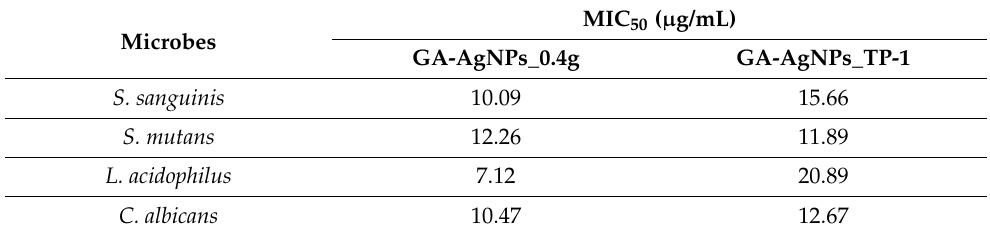
Table 5. MIC 50 for GA-AgNPs_0.4g and